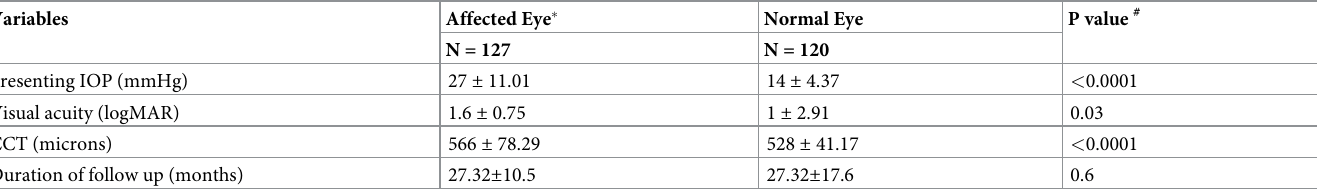
Table 1. Differences in baseline characteristics of affected eyes and normal eyes undergoing